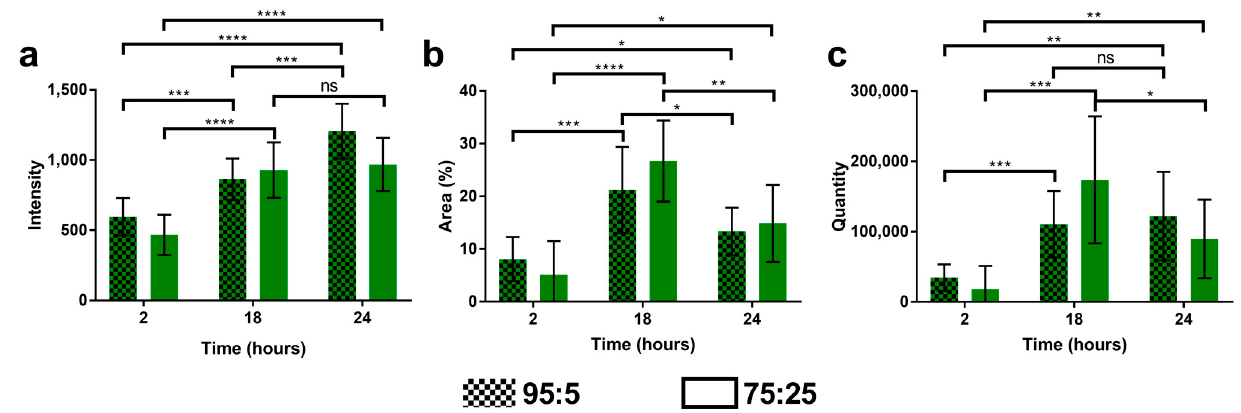
Figure 9. Quantification of fluorescence signal at 2,18 and 24 h for ( a ) intensity, ( b ) surface area, ( c ) quantity. MCEC cells were incubated with SqCsA/3a NPs at two ratios (95:5 and 75:25). Non- Significant (ns) p > 0.05, * p ≤ 0.05, ** p ≤ 0.01, *** p ≤ 0.001, **** p ≤ 0.0001.